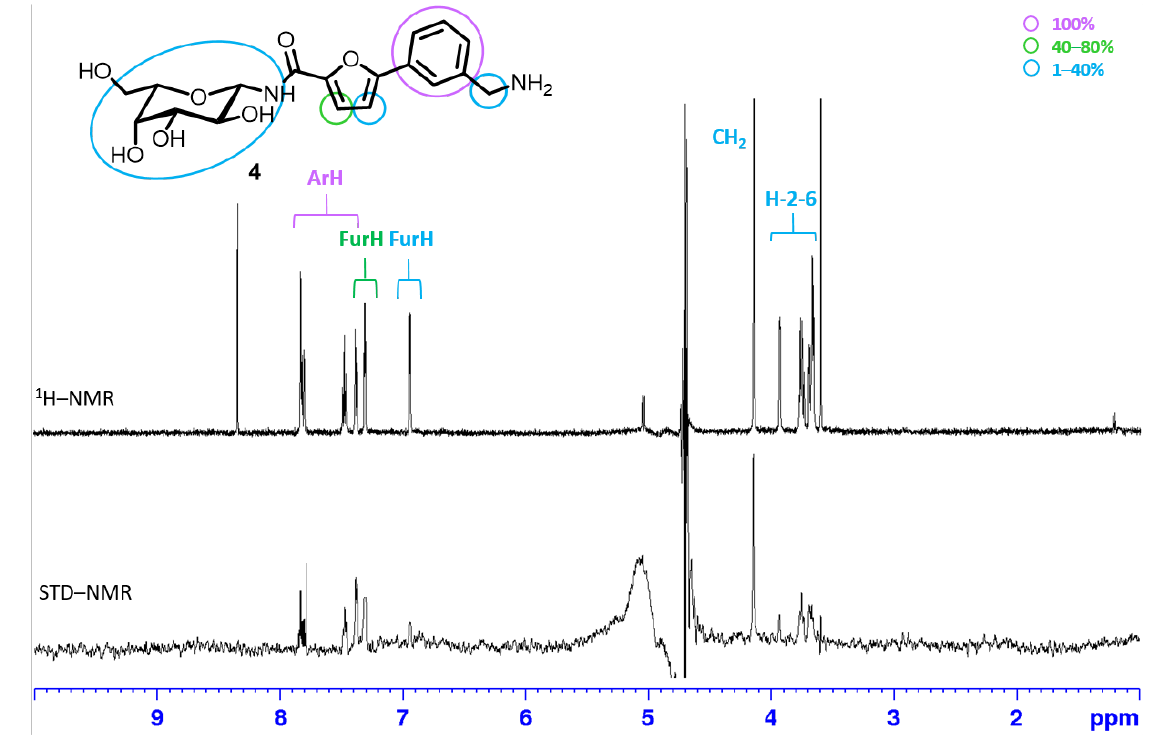
Figure 4. 1 H (top) and STD NMR (bottom) for compound 4 in presence of BC2L-C-Nt. The STD experiment was acquired on a Bruker Avance 600 MHz at 298 K, irradiating for 0.98 s at − 0.05 ppm in phosphate buffer, pH 7.4 with 10% D 2 O. The epitope is represented with a color code: purple circle for protons with 100% relative STD, green for 40 – 80% and light blue under 40%.